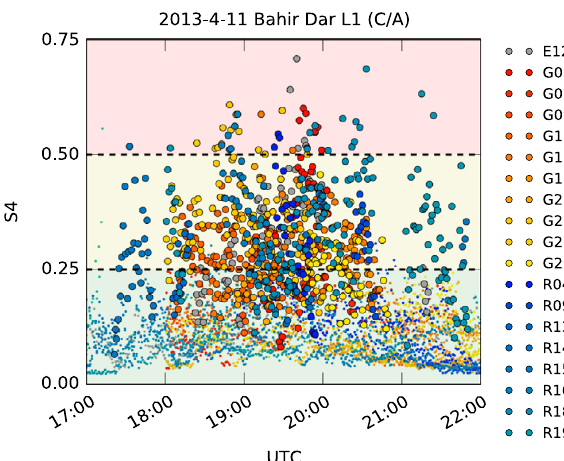
Figure 3. Scintillation indices S 4 for signals L1 (C/A)/E1 for all satellites tracked on 11th April 2013. The small dots are data points which have been removed by the soft-boundary algorithm and are not considered belonging to a scintillation event.